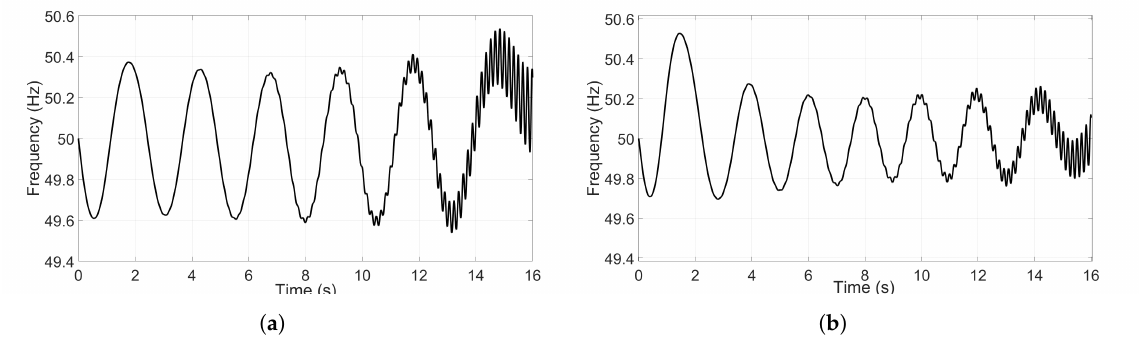
Figure 16. ( a ) Oscillatory frequency response when no additional frequency support is given by the IBG. ( b ) Oscillatory frequency response when frequency support is given by the IBG.